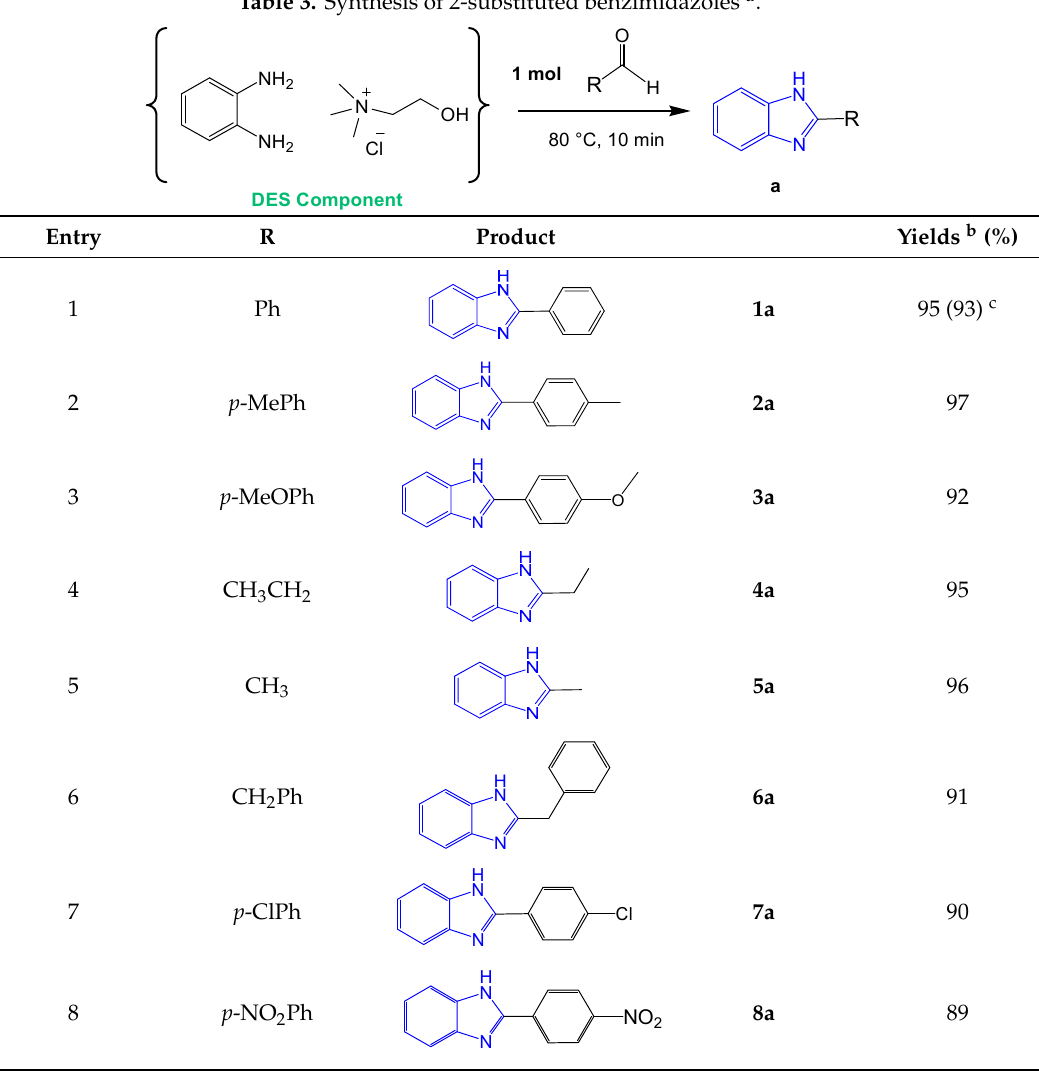
Table 4. Synthesis of 1,2-disubstituted benzimidazoles a .